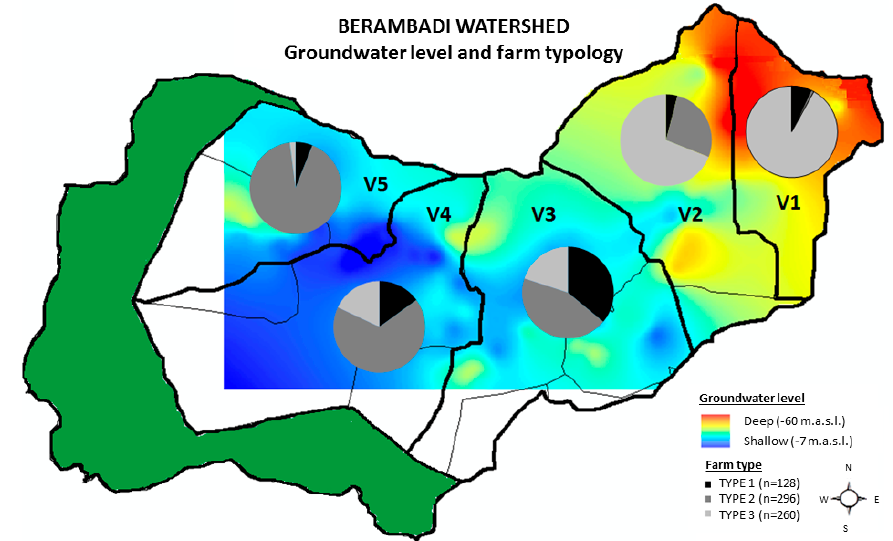
Figure 7. Groundwater table gradient (colors) and farm typology (pie chart) for each of the five villages (V1 to V5) on the Berambadi watershed. Type 1 are large, diversified and productivist farms. Type 2 are small, marginal rainfed farms. Type 3 are small, irrigable marketing farms. Grey lines refer to the borders of the 12 villages, green area describes the forest. The ground water level was obtained using disused borewells and measured at the end of 2012 monsoon (NB: no borewell was monitored in the forest and close by the forest leading to a partial map of ground water level).